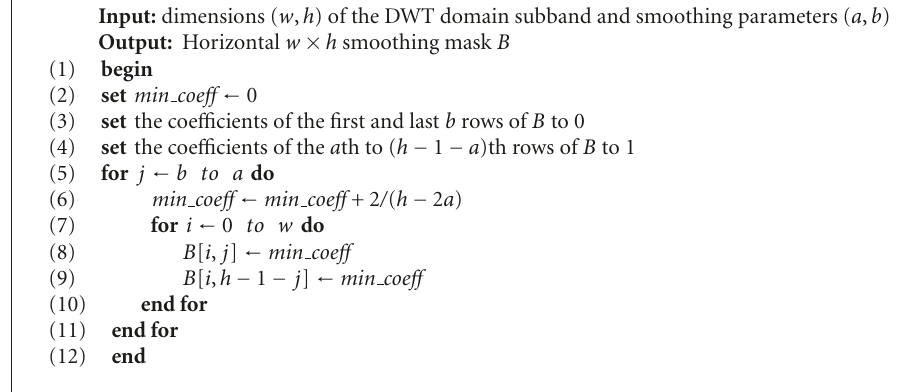
Algorithm 1: Example horizontal smoothing function.